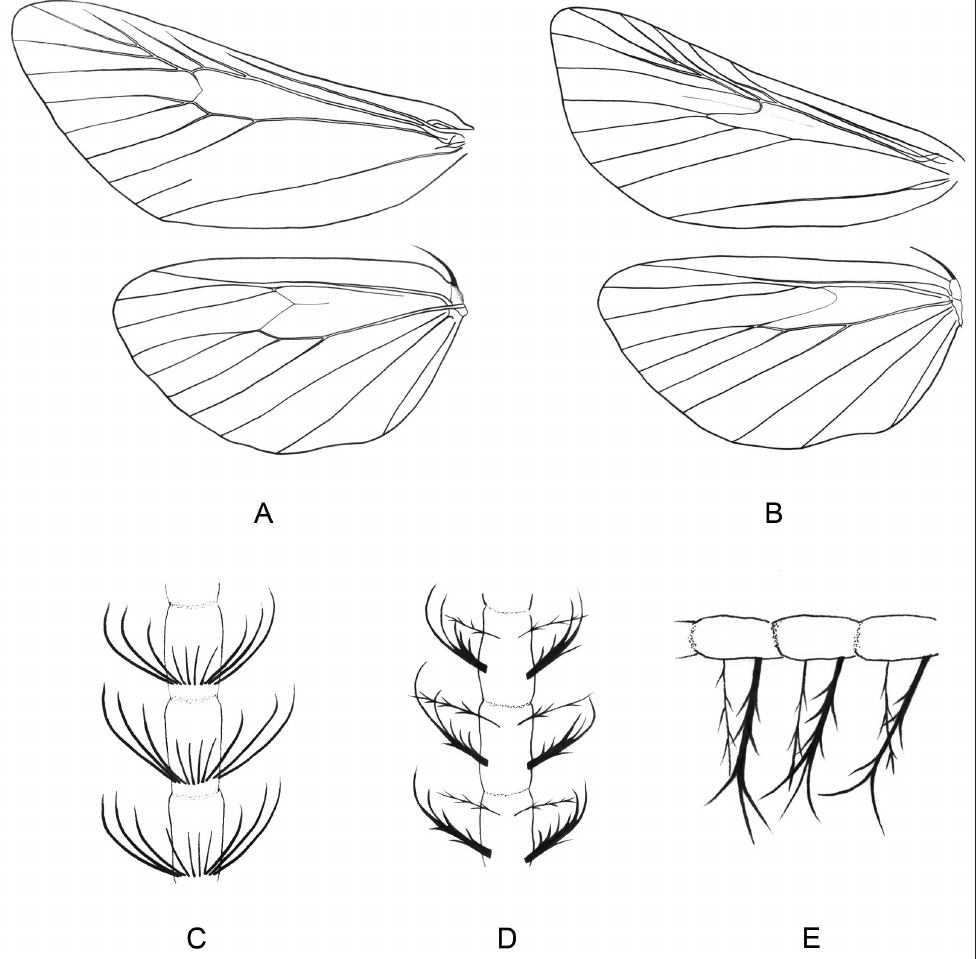
Figure 4. Wings venation ( A, B ) in A. kurdistanella ( A ) and S. brunnealis ( B ), and stylized drawings of ventral ciliae of the antennae ( C–E ) in A. gambronensis sp. n. ( C ) and S. brunnealis ( D, E ). C, D ) in ventral view, E ) in lateral view, showing ciliae of the left part.